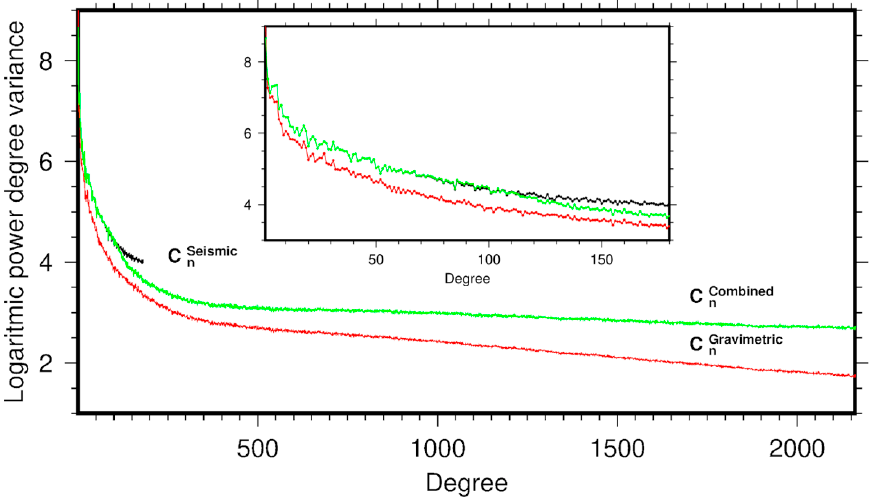
Figure 2. The logarithmic power–degree variances of the CRUST1.0 model (black), the VMM model (red), and the HRCM solution (green) obtained by applying the Butterworth filter.